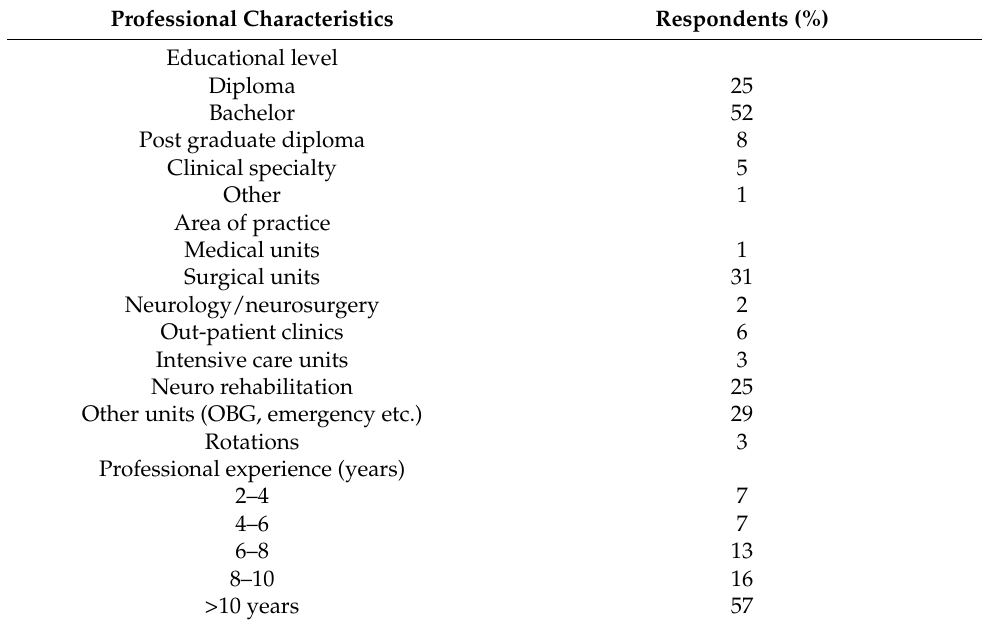
Table 1. Professional characteristic of the